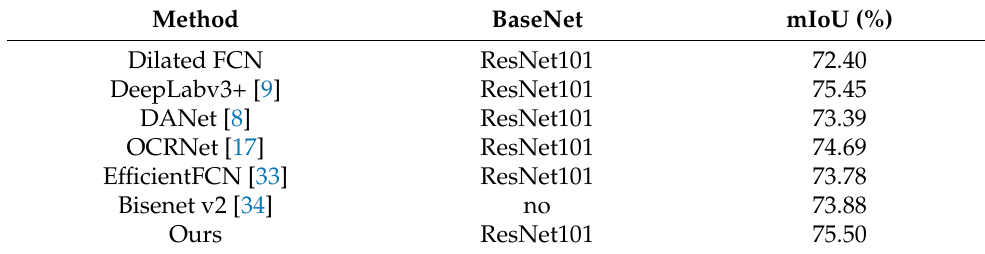
Table 4. Segmentation results on PASCAL VOC 2012 validation set.